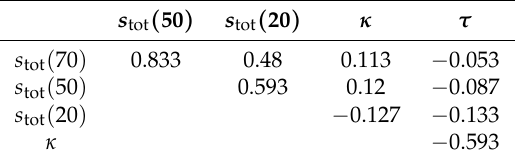
Table 3. Correlation coefficients, uncompressed GDL. q in